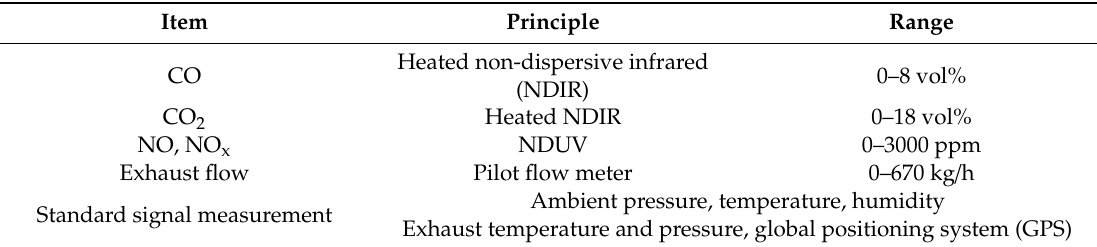
Table 6. Specifications of portable emissions measurement system (PEMS) used in this